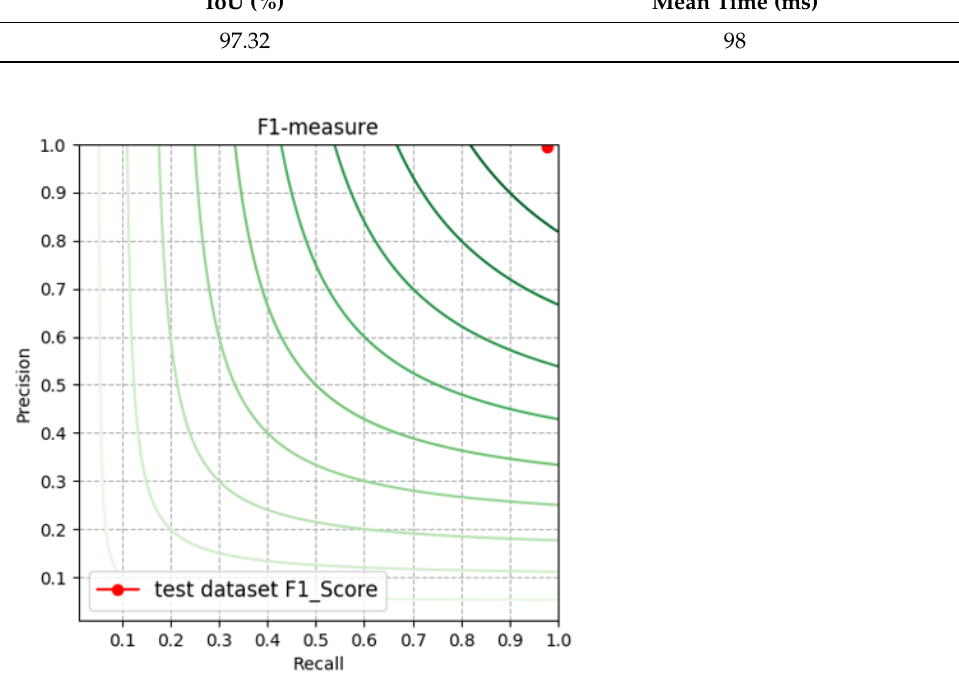
Table 2. Segmentation performance of DeepLabV3+.